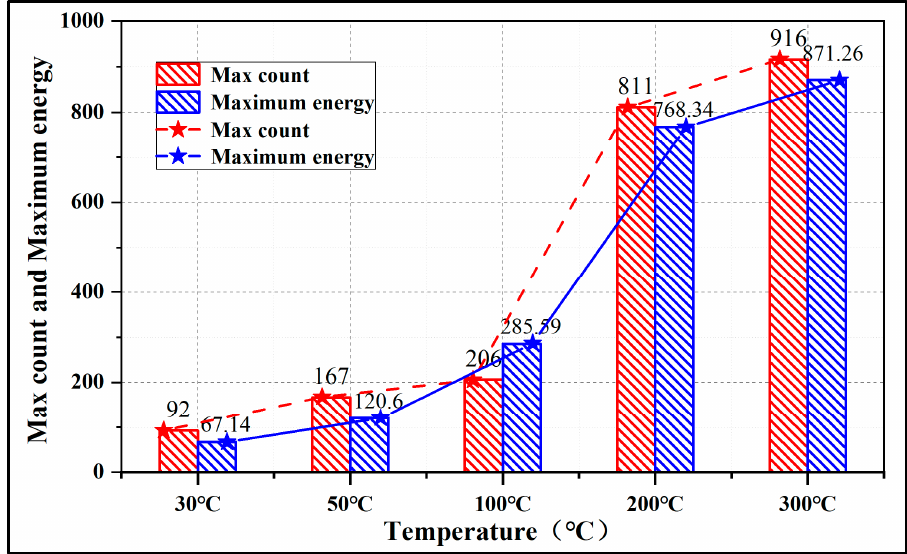
Figure 6. Maximum count and maximum energy of AE in different temperature segments.